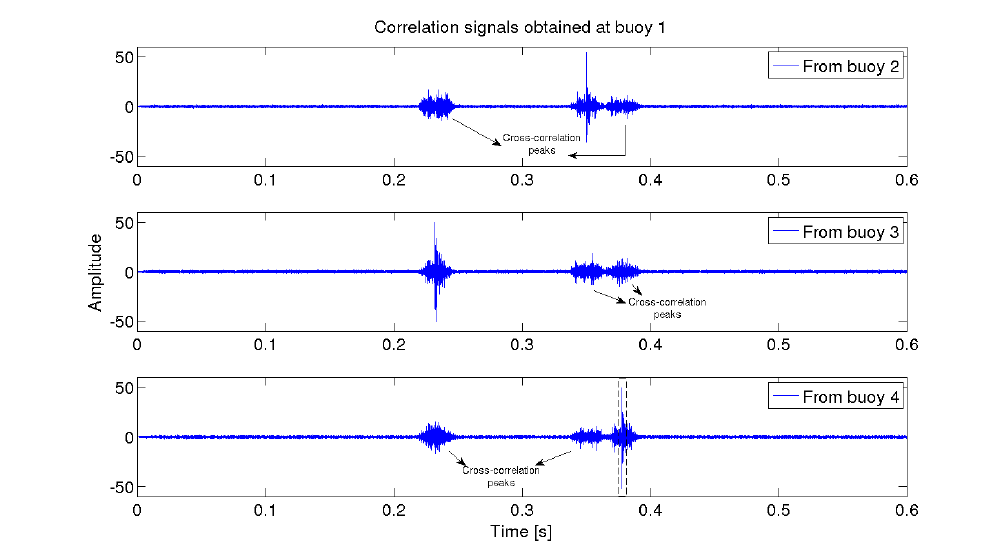
Figure 3. Correlation peaks at fixed buoy